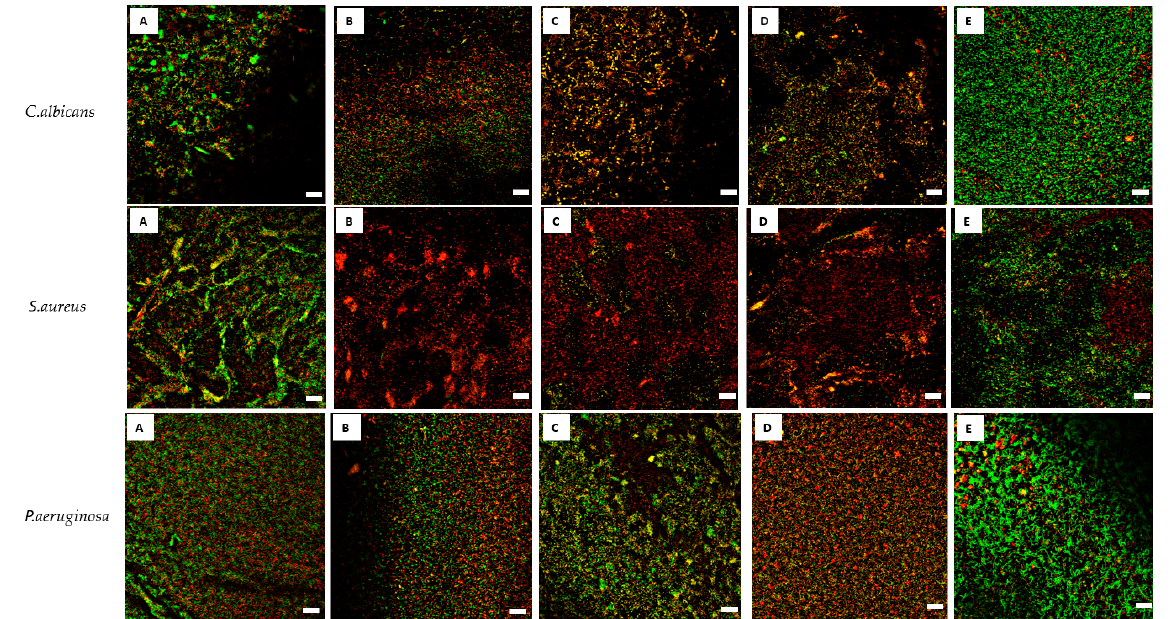
Figure 4. Live/dead images of biofilm-forming cells forming on a cellulose carrier subjected to the antiseptics for 1 h. ( A ) untreated biofilm (no antimicrobial solution); ( B ) 30% H 2 O 2 , biofilm treated with 30% hydrogen peroxide, i.e., compound of strong antimicrobial activity; ( C ) biofilm treated with P antiseptic; ( D ) biofilm treated with O antiseptic; ( E ) biofilm treated with M antiseptic. Green—live cells, red/orange—dead cells. The white bars in the right lower part of every picture are of 50 μ m of longitude. Please also refer to supplementary data Figures S6 and S7 where pictures of bigger size with characters and typical points are presented.